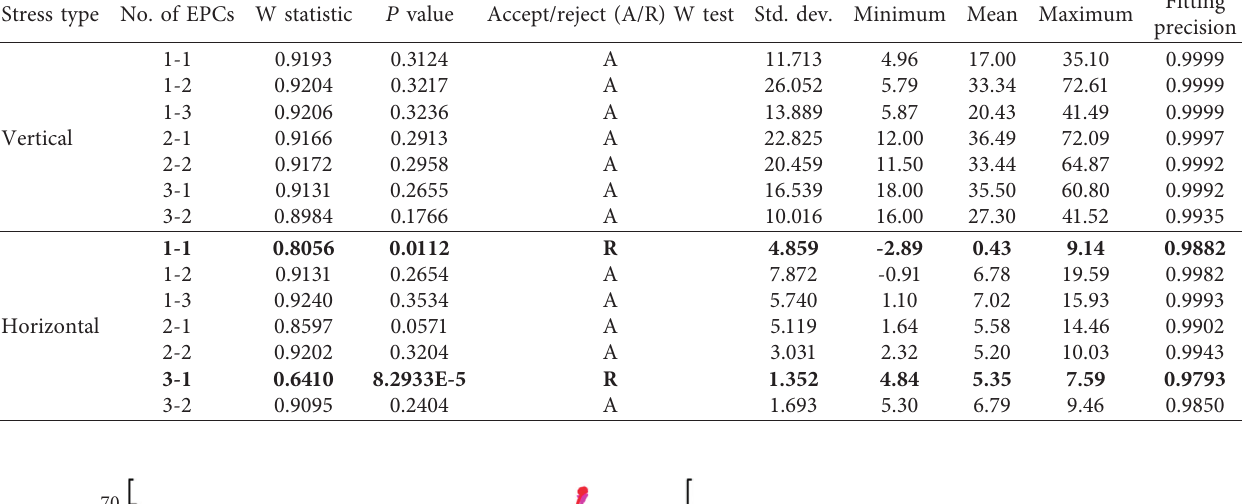
Table 2: Reliability verification of measured stresses in the loading zone.